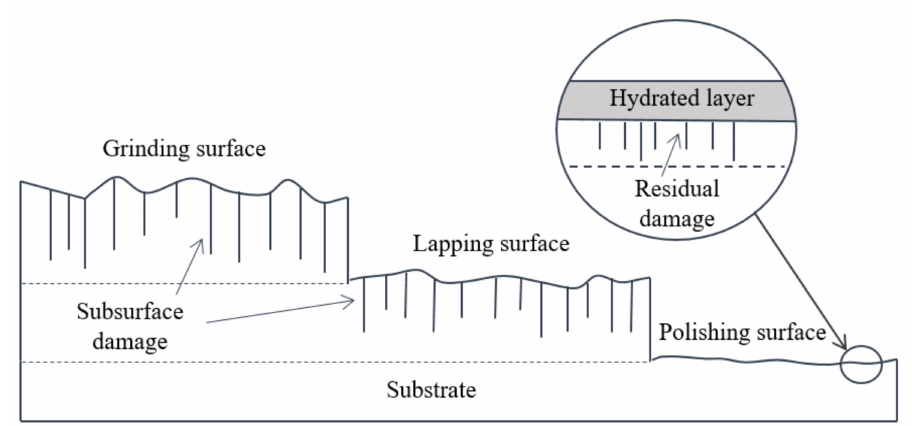
Figure 1. The schematic view of sub-surface damage (SSD) from grinding to